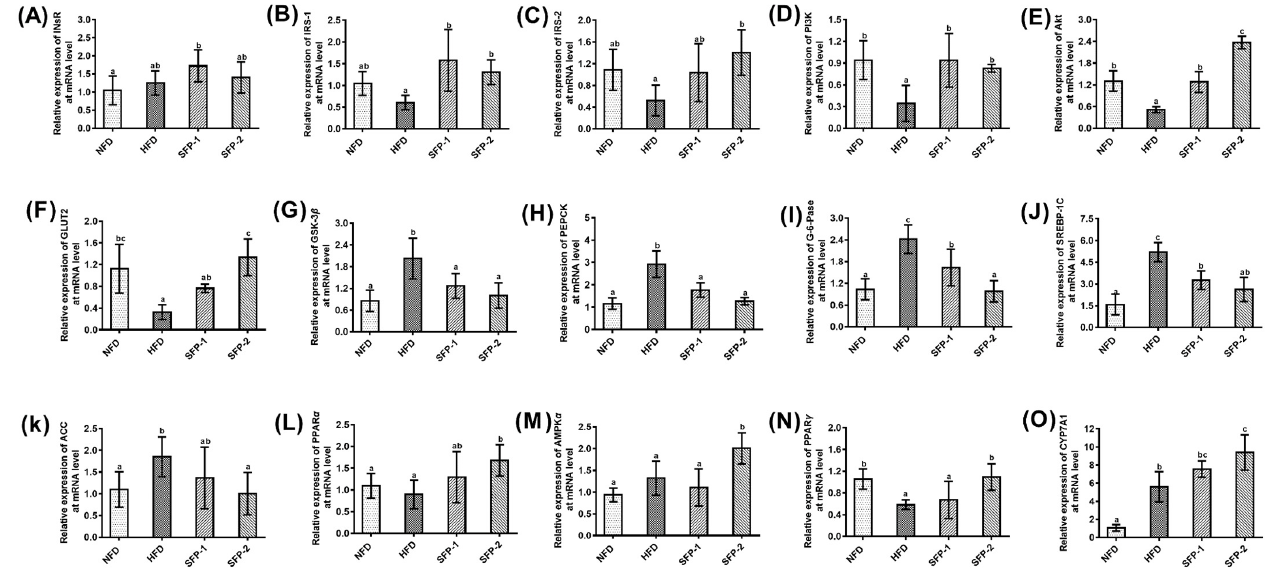
Figure 8. Effects of SFPs on expression of Ins R ( A ), IRS-1 ( B ), IRS-2 ( C ), PI3K ( D ), Akt ( E ), GLUT2 ( F ), GSK-3 β ( G ), PEPCK ( H ), G-6-Pase ( I ), SREBP-1C ( J ), ACC ( K ), PPAR α ( L ), AMPK α ( M ), PPAR γ ( N ) and CYP7A1 ( O ) of liver in diabetic rats. The different letters represent significant difference ( p < 0.05).